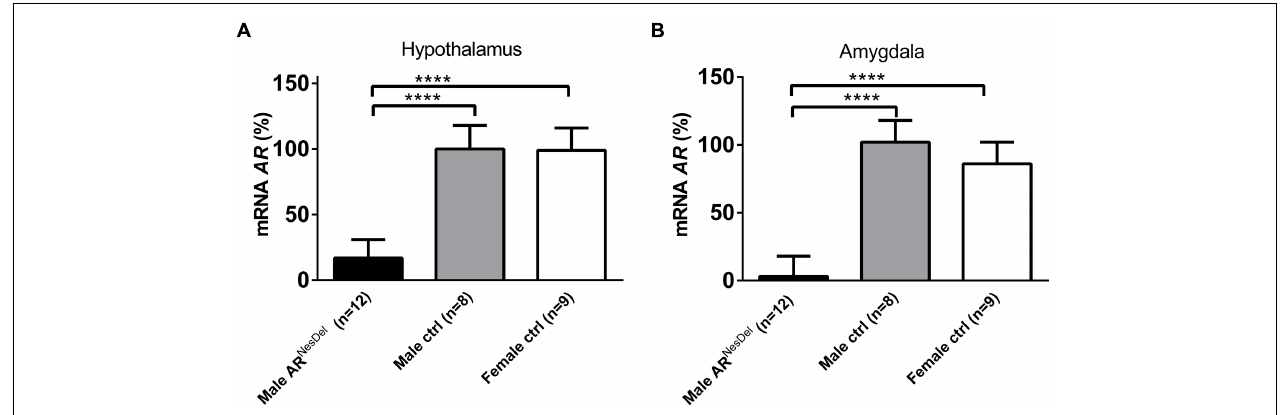
FIGURE 6 | Ar mRNA expression levels (A) in the hypothalamus and (B) in the amygdala of male AR NesDel , as well as in male (wildtype, AR flox , NesCre + / − ) and female (wildtype, ARflox + / − ) controls. The results are presented as percent ( ± SEM) in relation to the male control group. ∗∗∗∗ p < 0.0001.